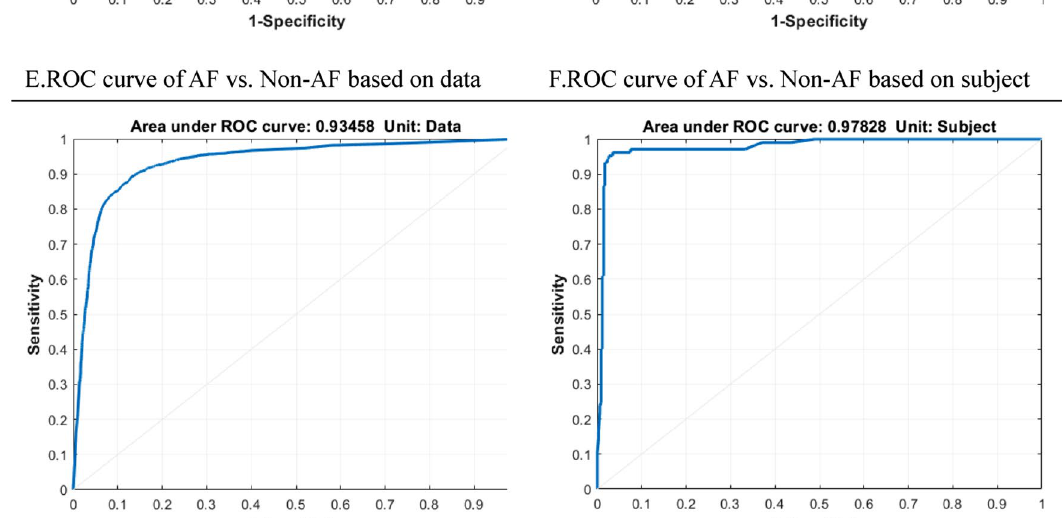
Figure 4. Performance of the deep-learning models for classification of atrial fibrillation based on 30-s segment data and whole-length recording of subjects. AF atrial fibrillation, NSR normal sinus rhythm, ROC receiver operating characteristic. Receiver operating characteristic (ROC) curves based on data of 30-s segments (Left) and voting results of whole-length recording of subjects (Right) in the datasets: “AF vs NSR” (Fig. 2A,B), “AF vs Others” (Fig. 2C,D), “AF vs Non-AF” (Fig. 2E,F). By voting algorithm, subject who had more than 50% of model-determined AF segments was classified as AF